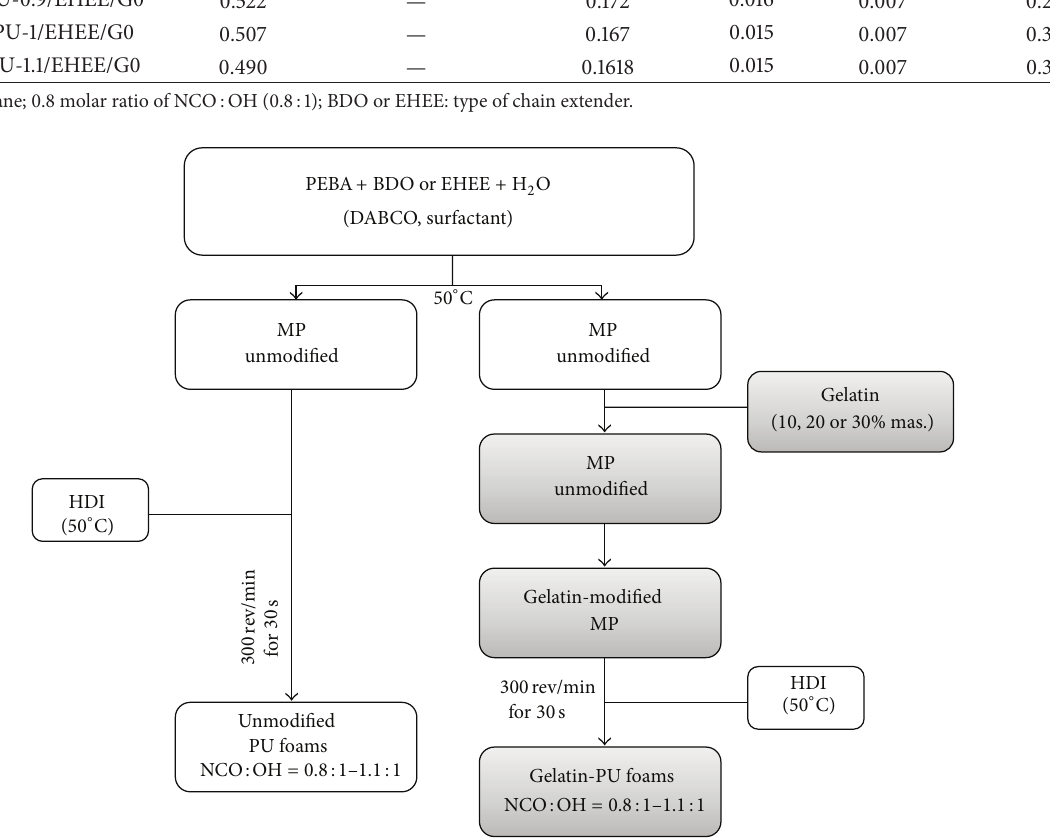
Figure 1: Synthesis of unmodified and gelatin-modified polyurethane